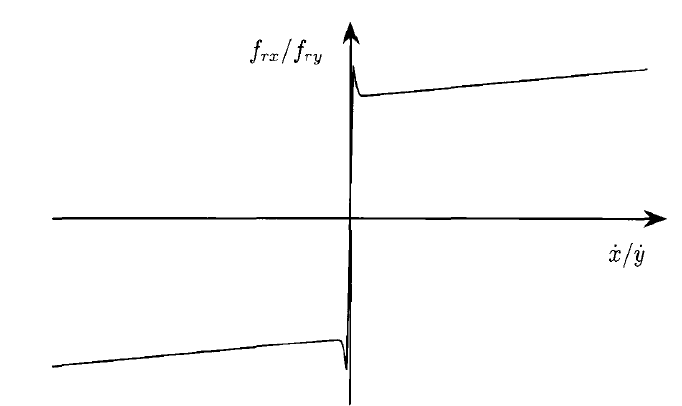
Figure 3: Friction relationship with the vehicle